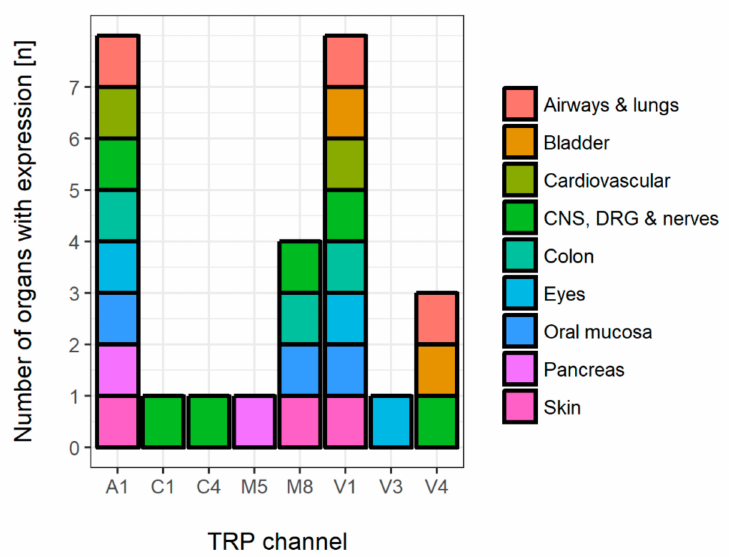
Figure 5. Overall numbers and subtypes of TRP channel expression with chemosensory properties. According to the considered literature in this review, TRPA1, TRPM8, and TRPV1 were identified as the most abundant channels. Colors represent organ-related